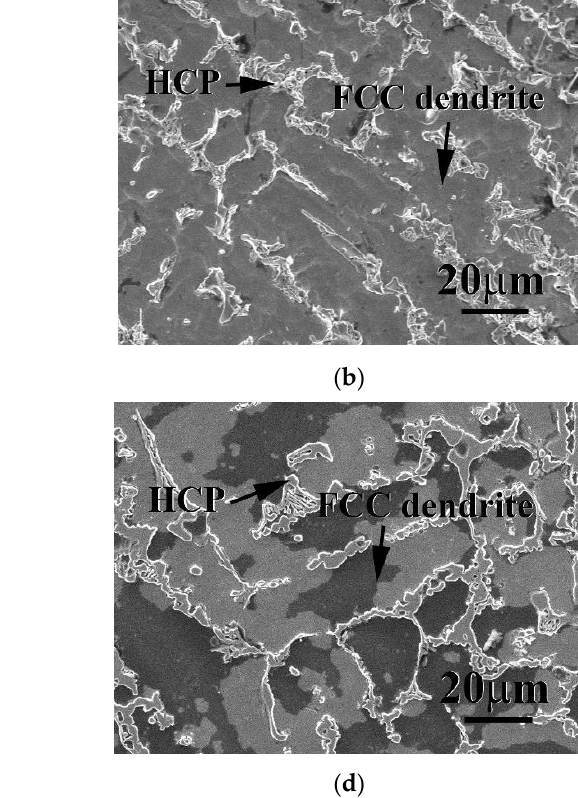
Figure 7. Morphologies of the Cr 27 Fe 24 Co 18 Ni 26 Nb 5 alloy after polarization in ( a ) deaerated 1 N H 2 SO 4 solution at 30 °C, ( b ) deaerated 1 N H 2 SO 4 solution at 50 °C, ( c ) deaerated 1 N HCl solution at 30 °C, and ( d ) deaerated 1 N HCl solution at 50 °C.